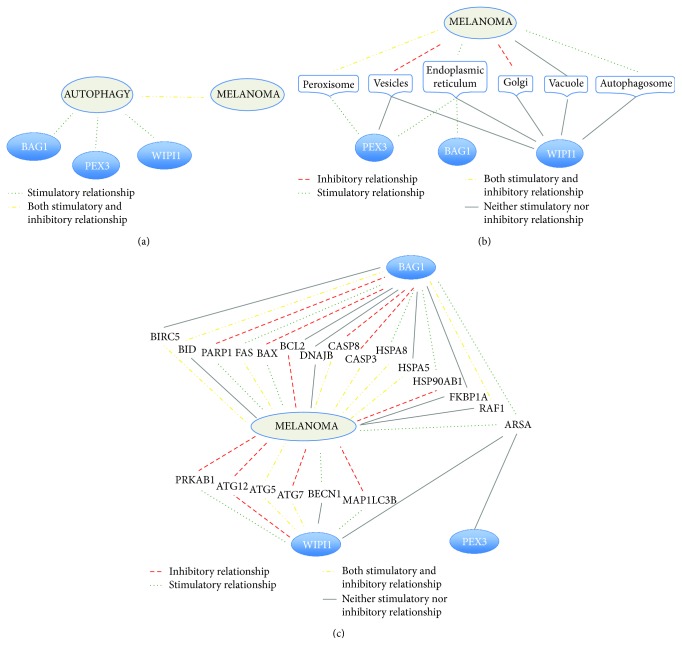
Functional relations reported in Pubmed abstracts, according to Chilibot analysis. Only strong interactive relationships are reported (i.e., interactive relationships reported by at least 5 Pubmed abstracts). Green dotted lines indicate stimulatory relationships; yellow dashed/dotted lines indicate both stimulatory and inhibitory relationships; red dashed lines indicate inhibitory relationships; and continuous gray lines indicate neither stimulatory nor inhibitory relationship, according to Chilibot categories. (a) None of the 3 selected autophagy-related genes has any direct known interactive relationship with melanoma; rather, the relationships are all mediated by autophagy. This indicates that the proposed role of BAG1, PEX3, and WIPI1 in melanoma is novel. (b) Strong interactive relationships of the 3 genes occur with intracellular vesicles, and, through these, they may relate to melanoma. (c) Strong interactive relationships of all 222 ARGs taken from Supplementary Table 1 with melanoma were investigated. Neither BAG1, nor PEX3 nor WIPI1, has a direct strong interactive relationship with melanoma. BAG1 may have indirect strong interactive relationships with melanoma, mediated by BIRC5, BID, PARP1, FAS, BAX, DNAJB, and many others. WIPI1 interaction with melanoma is mediated by PRKAB1, ATG12, ATG5, ATG7, BECN1, and MAP1LC36. Interestingly, ARSA is the only autophagy-related gene having known strong interactive relationships with both BAG1, PEX3, and WIPI1 and with melanoma.